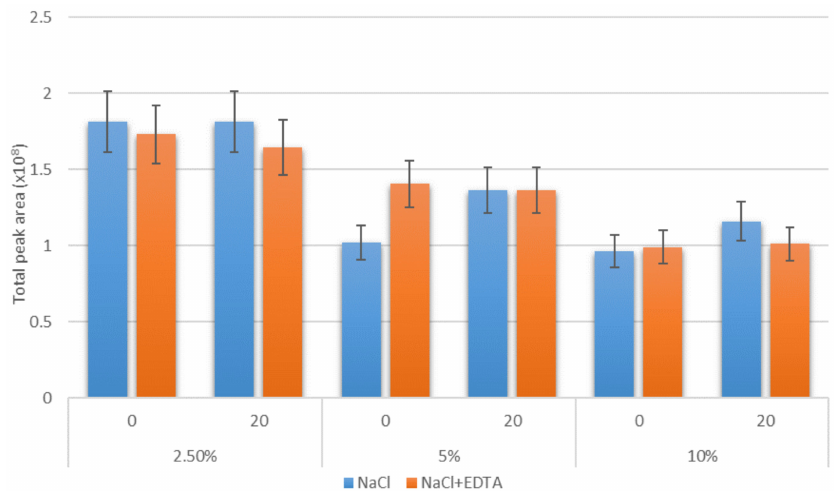
Figure 2. The e ff ect of the addition of EDTA on volatile sulfur compounds (VSCs) extraction without (0% w / v ) and with (20% w / v ) NaCl treatment at di ff erent alcohol concentrations (2.5%, 5%, and 10% v / v ). Extraction temperature: 50 ◦ C, extraction time: 15 min; SPME fiber: DVB / CAR / PDMS.